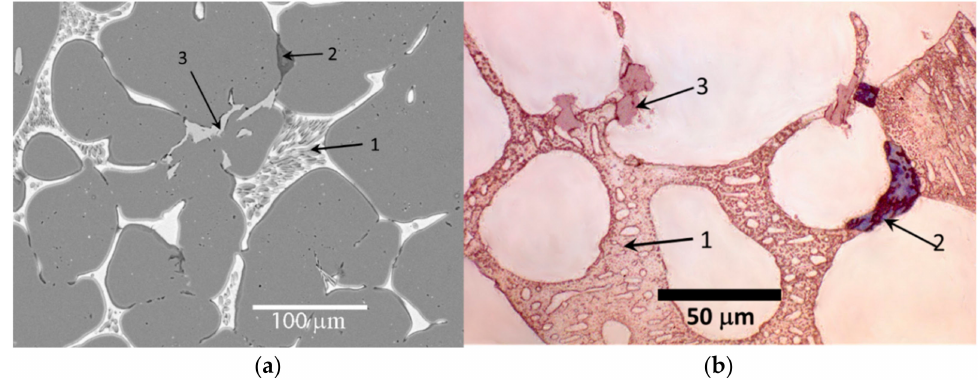
Figure 2. Identification of phases: (1) τ -AlMgZn (Al 2 Mg 3 Zn 3 ), (2) Mg 2 Si, (3) Al 3 Fe; by ( a ) images obtained from scanning microscopy (200 × ) and ( b ) image from optical microscopy (500 × ).